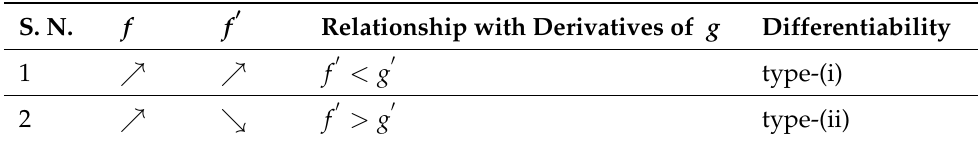
Table 1. Nature of the function and type of differentiability; (cid:37) and (cid:38) stand for increasing and decreasing functions,